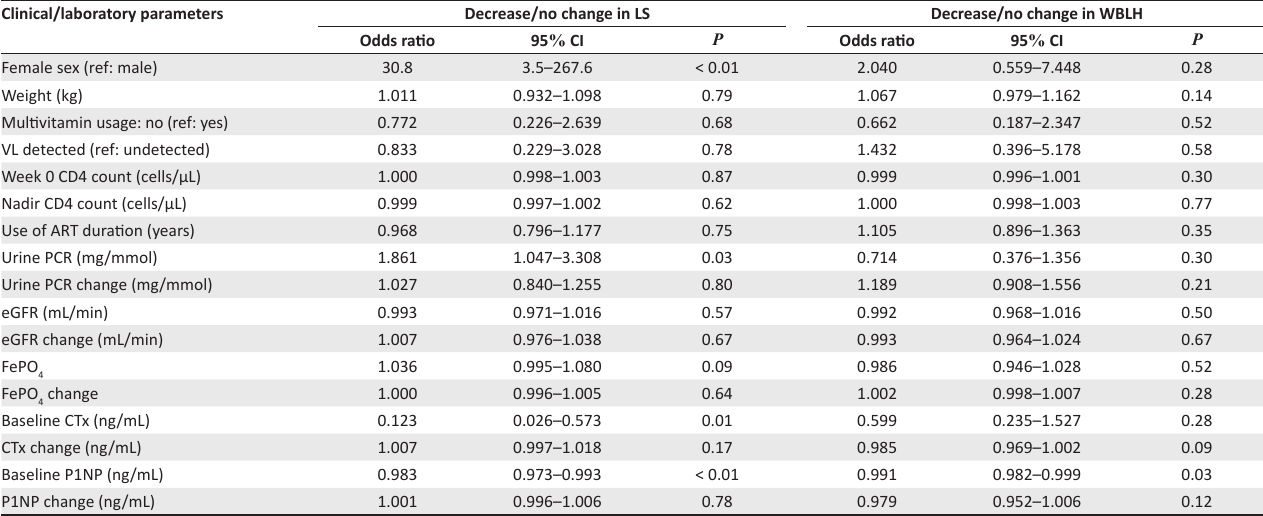
TABLE 3: Univariate logistic regression modelling associations between outcomes (decrease/no change in LS and WBLH BMD) and clinical and laboratory parameters. Clinical/laboratory